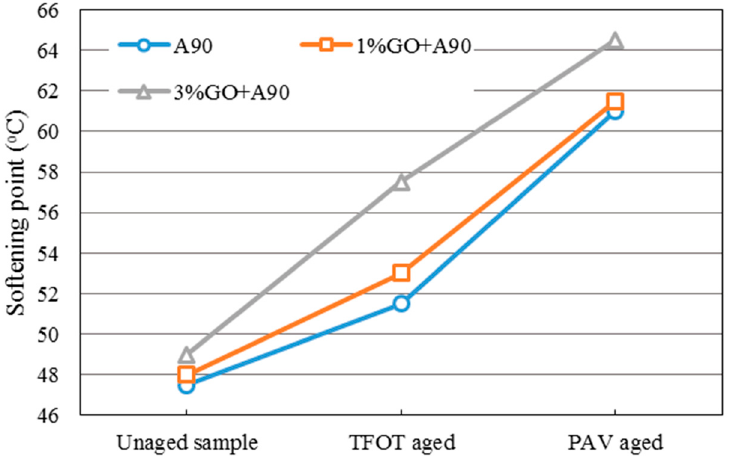
Figure 4. Softening point of GO-modified 90A and its matrix before and after aging.